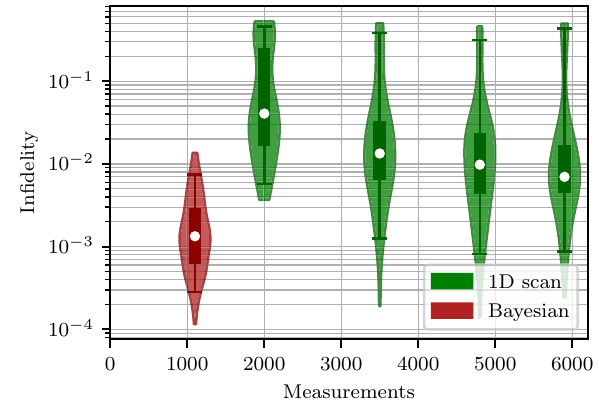
FIG. 12. Simulation of manual tuneups using 1D scans for four different measurement budgets compared to the data obtained using the Bayesian method. The distribution of infi- delities is shown as a violine plot, with median, quartiles, and 5–95 percentiles indicated. For all four settings under consider- ation, the method has a 21 ( 2 ) % rate of failure. For all settings, the median simulated parameter infidelities are larger than the infidelities obtained from the Bayesian